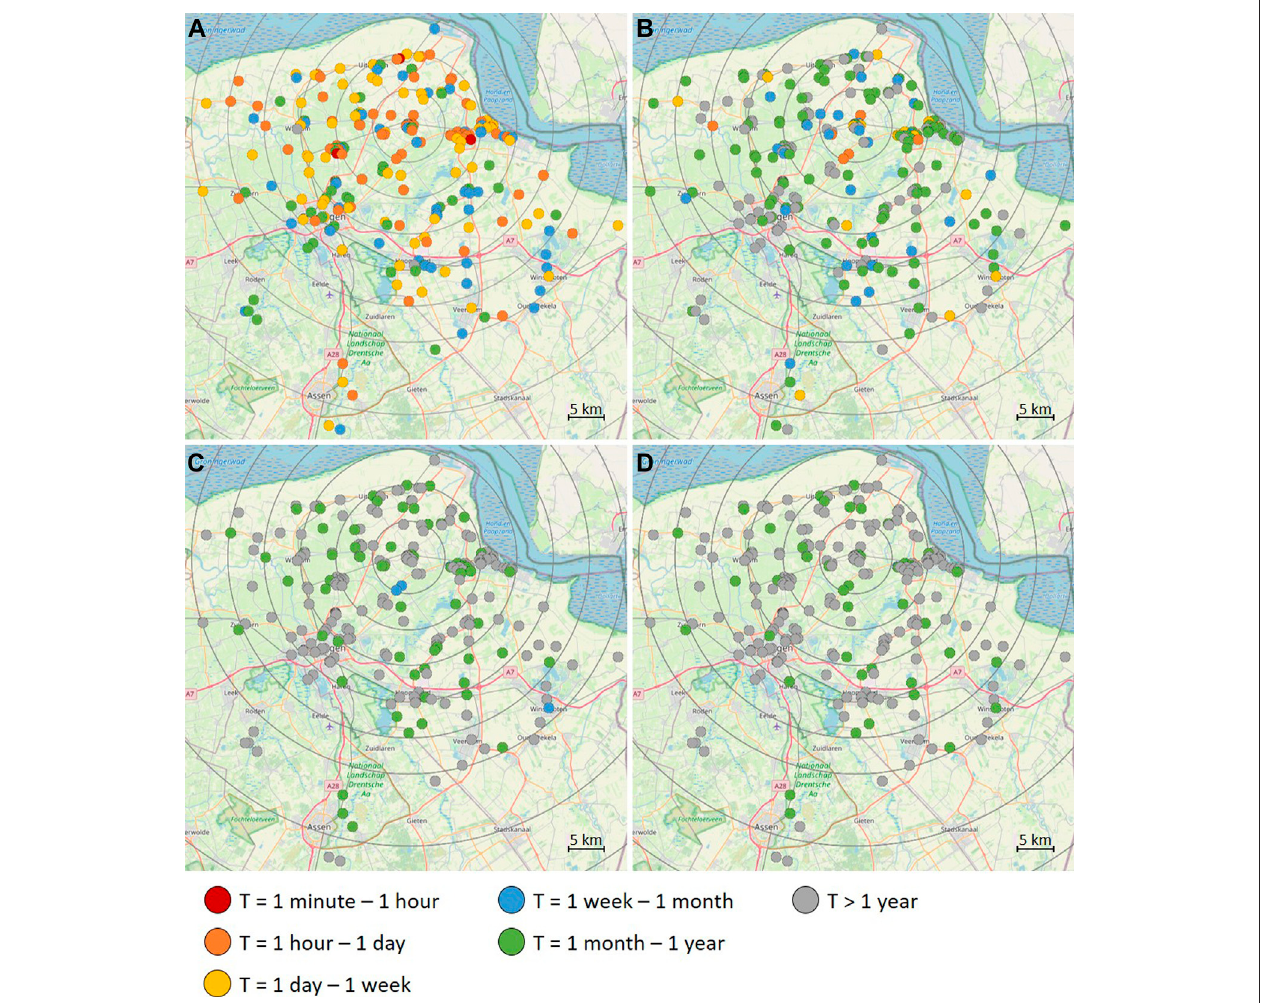
FIGURE5| Returnperiodsdeterminedfromthe1-yearheartbeatdataforvelocitythresholds: (A) v (cid:1) 0.3mm/s, (B) v (cid:1) 1mm/s, (C) v (cid:1) 3mm/sand (D) v (cid:1)